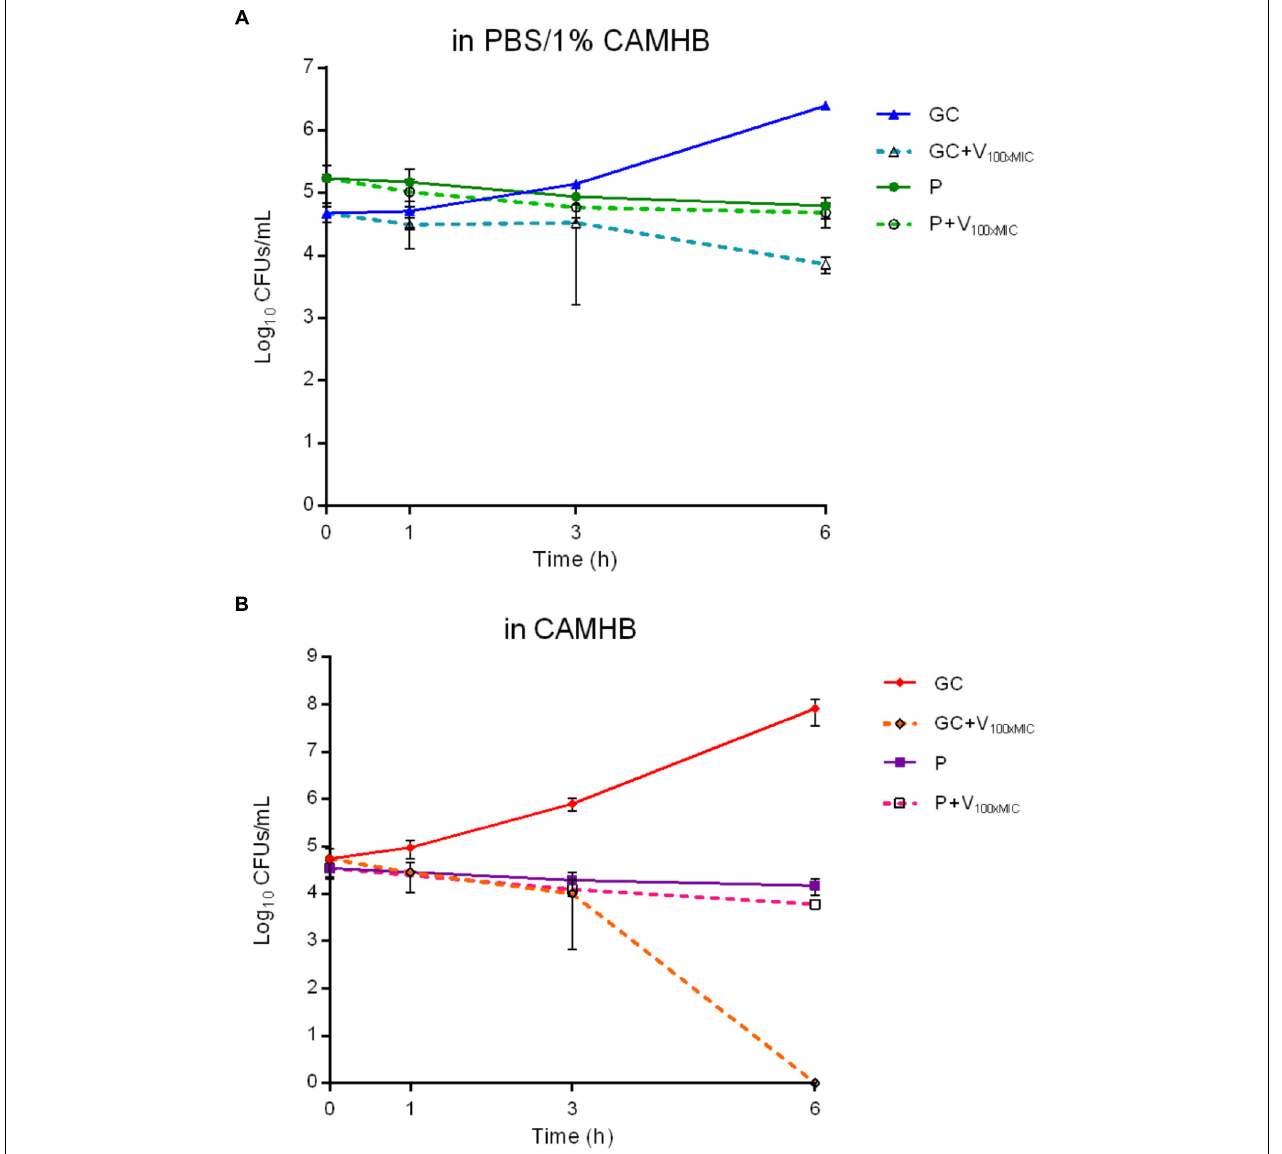
FIGURE 6 | Characterization of persister cells isolated from MRSA biofilm after 24 h-treatment with 1024 µ g/ml vancomycin. The exposure to high bactericidal concentrations of vancomycin (100x MIC VAN = 100 µ g/ml) was evaluated by colony counting (Log 10 CFUs/mL) of MRSA persister cells during 6 h-incubation in (A) PBS/1% CAMHB and (B) CAMHB. GC, growth control; GC+V 100xMIC , growth control exposed to 100xMIC vancomycin; P, persister cells; P+V 100xMIC persister cells exposed to 100xMIC vancomycin. Data are expressed as mean ± SD, 3 ≤ n ≤